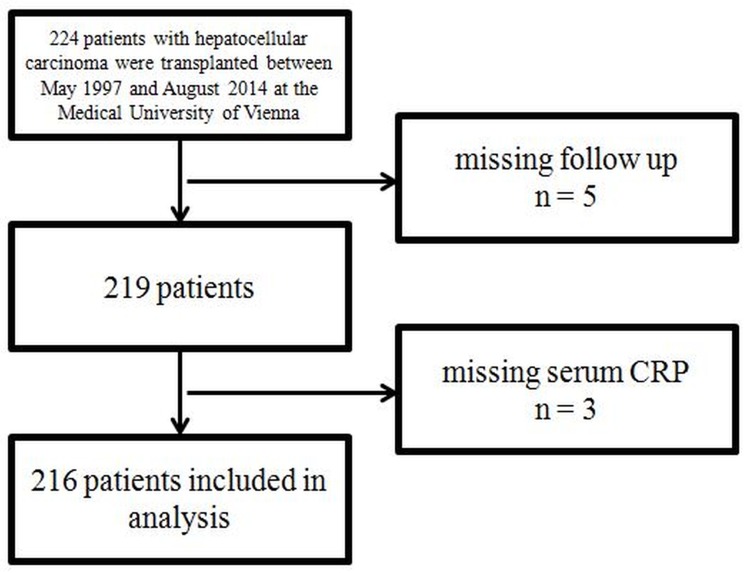
Patient flow chart.